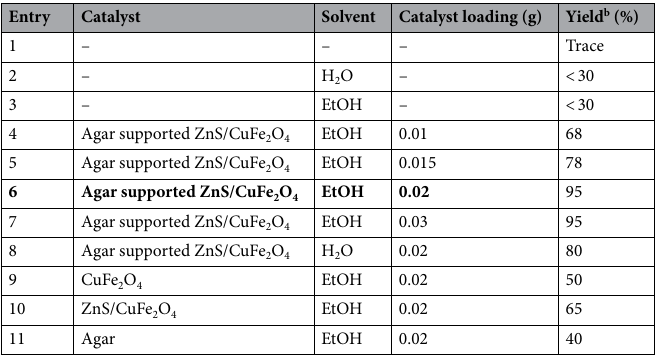
Table 1. Optimizing the four component reaction conditions for the synthesis of dihydropyrano[2,3-c] pyrazole derivatives a . a Reaction conditions: 1 mmol ethyl acetoacetate, 1.2 mmol hydrazine hydrate, 1 mmol 3-nitrobezaldehyde and 1 mmol malononitrile, catalyst (10–20 mg). b The yields relate to the isolated product, at r.t. Significant values are in bold.